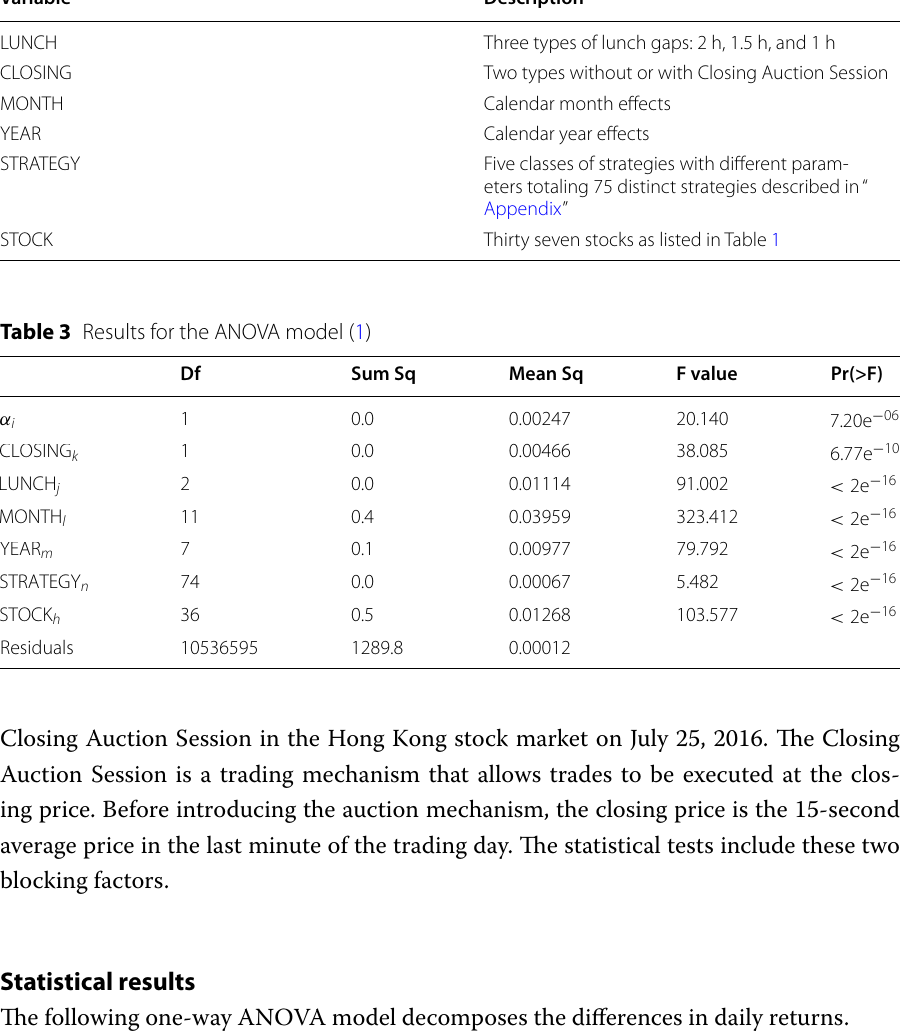
Table 2 Blocking factors for ANOVA model (1) Variable Description LUNCH Three types of lunch gaps: 2 h, 1.5 h, and 1 h